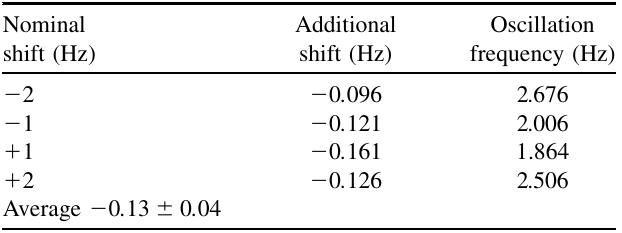
TABLE III. Corrections to the rf-solenoid frequency shifts.